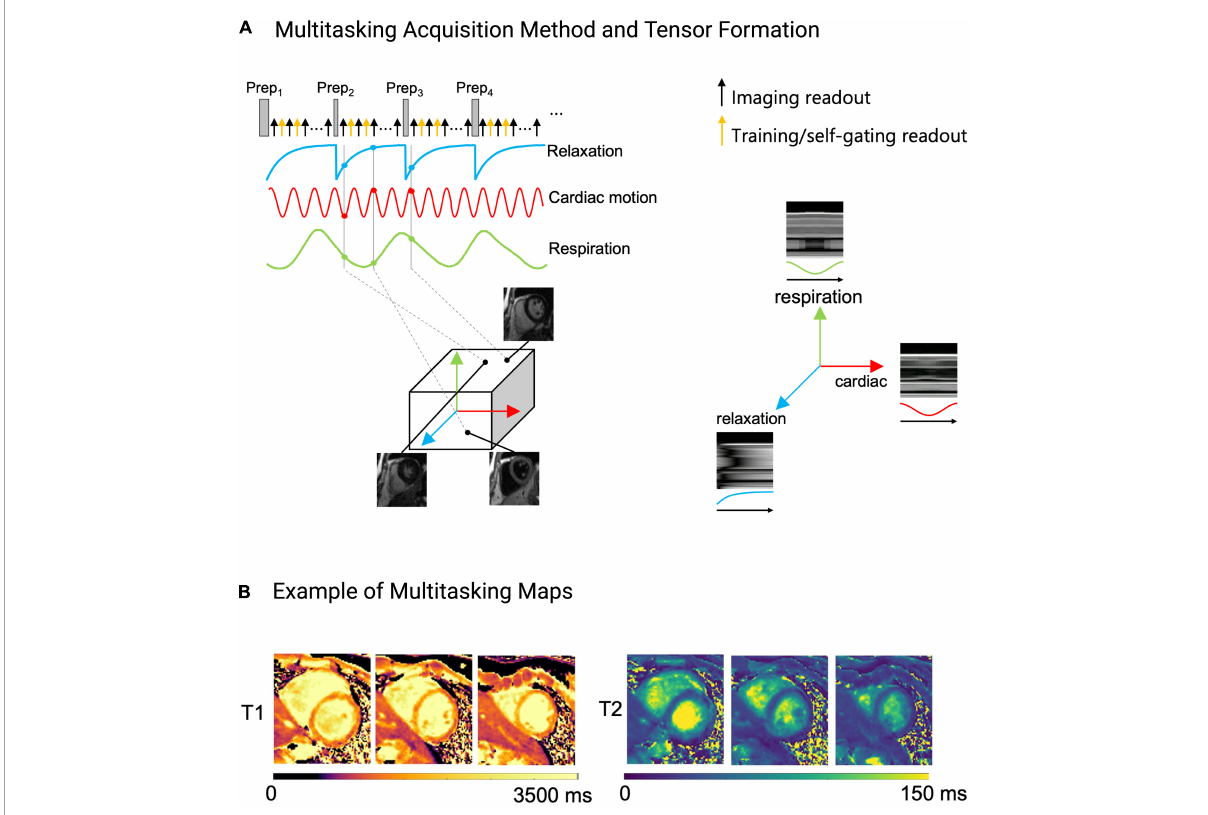
FIGURE9 Example of the Multitasking acquisition method. (A) To capture T1 and T2 contrasts simultaneously, a hybrid T1/T2prep pulse is used in a continuous acquisition. Training/self-gating readouts are also acquired for retrospective cardiac and respiratory binning, and to estimate basis functions. Multi-dimensional information, namely cardiac and respiratory motion, and relaxation rate are extracted from the acquired data and sorted into a tensor. Each dimension in the tensor depicts cardiac motion, respiratory motion, T1 relaxation or T2 relaxation. One can choose any point within the tensor to obtain an image at a specific respiratory position, cardiac position, and relaxation position. (B) Example of the fitted Multitasking T1 and T2 maps. These maps are fitted after data are sorted into their tensor